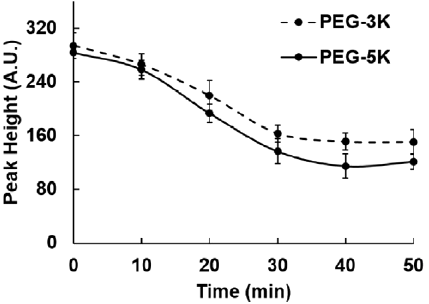
Fig. 11. Dynamics of peak height for PEG-3 K and PEG-5 K nanoparticle aggregates measured by IVFC ð n ¼ 3 Þ .